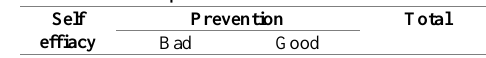
Table 4 indicates that personality factor had less correlation with cervical cancer prevention behavior. Respondents who had positive personality behavior tended to had good prevention behavior, but still a few number of respondents who had negative personal factor also had good prevention behavior. Tabel 5. Correlation between self efficacy and cervical cancer